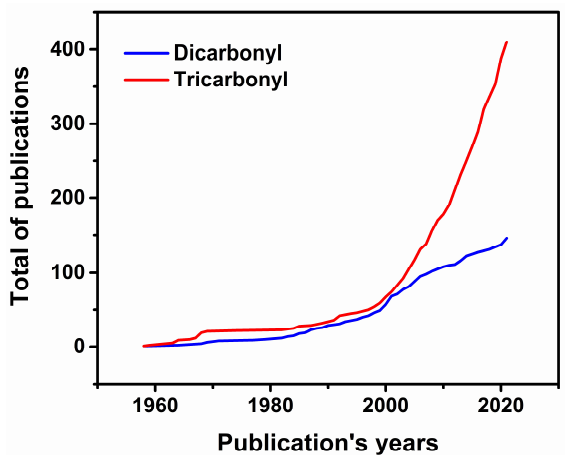
Figure 9. Progressive sum of publications of rhenium dicarbonyl (blue) and tricarbonyl (red) complexes as a function of the year. Queries were performed on 23 November 2021 with Scifinder employing the following key words: “rhenium dicarbonyl complexes” and “rhenium tricarbonyl complexes”.